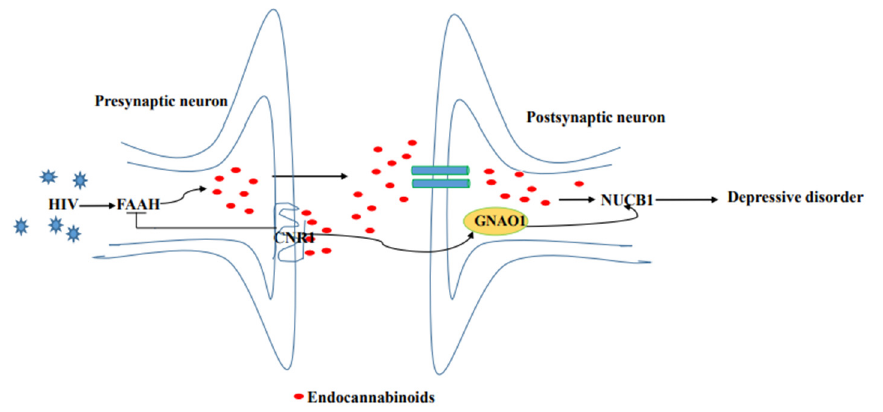
Figure 5. Proposed model of the molecular events in NUCB1-mediated HIV comorbid depression.